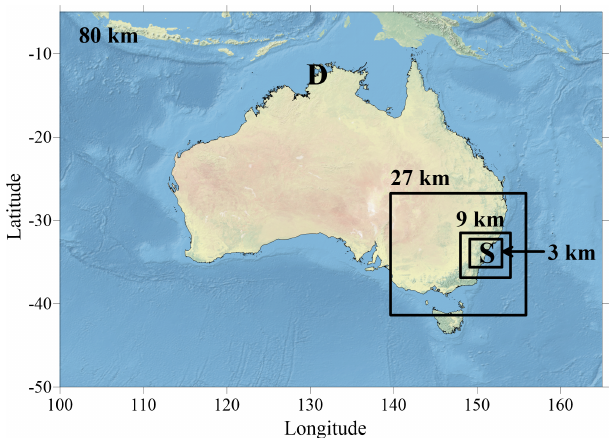
Figure 1. Map to show nests of model domains from 80km Australia-wide to 3km inner Sydney domain. “S” and “D” mark the locations of Sydney and Darwin, respectively.